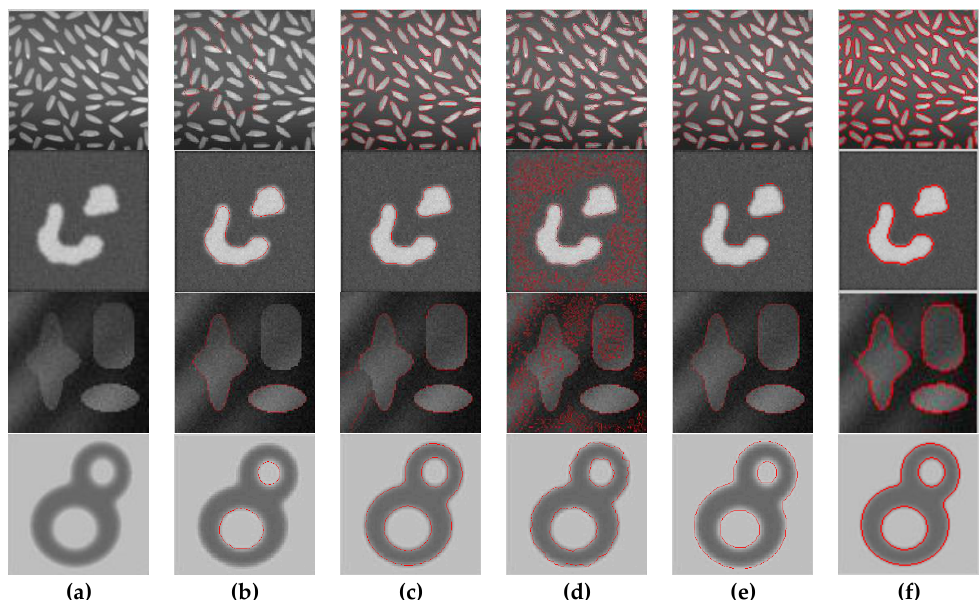
Figure 4. Comparisons of the five models in segmenting multiobjective images: (a) The original image; (b) The segmentation results of the DRLSE model; (c) The segmentation results of the LBF model ; (d) The segmentation results of the LIF model ; (e) The segmentation results of the LSACM model ; (f) The segmentation results of the IRLS-IS model .